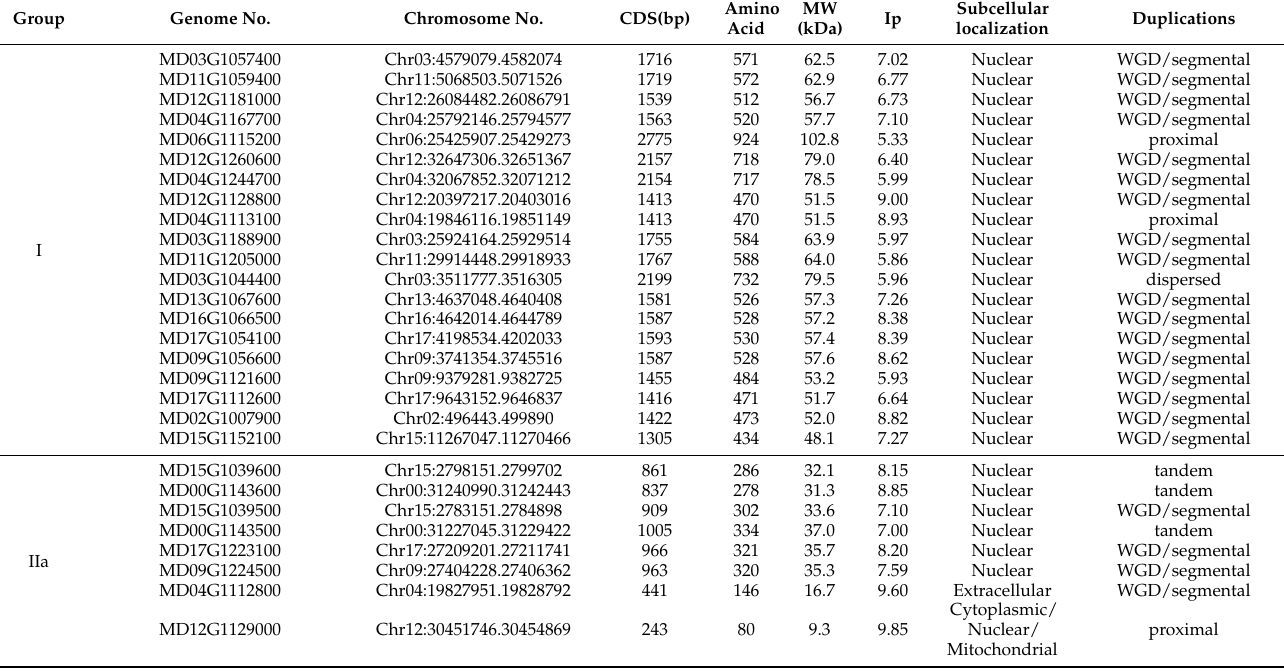
Table 1. List of the identified WRKY genes in M. domestica with their detailed information. Group Genome